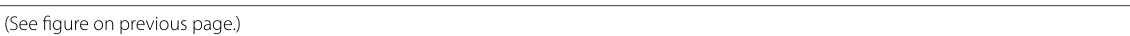
figure on previous Fig. 7 Cellular analysis in intestinal biopsies and PBMC from active versus controlled FPIES. Cellular analysis was performed on cells extracted from sigmoid biopsies obtained from children presenting controlled FPIES (non‑active) or active FPIES. Cells were labelled and analyzed by flow cytometry using a NovoCyte flow cytometer and analysis was performed using NovoExpress ™ software (Version 1.2.1; ACEA Biosciences, Inc.). Percentages of ILC1; ILC2, or ILC3 cells among parent cells (CD45 + CD127 + ) and grandparent cells (Lin − SSC low ) are indicated in colour and in brackets, respectively. Lin: mix of labelled anti‑human CD3, CD11c, CD14, CD16, CD19, CD56, Fc ε RI α , CD1a,